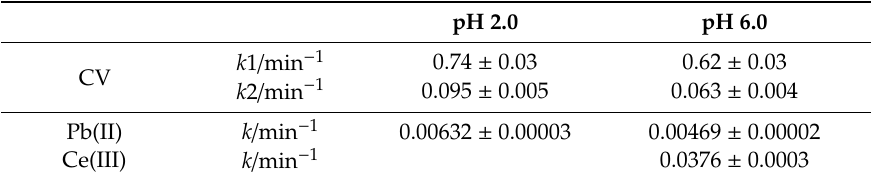
Table 4. Rate constant values for pseudo-first order and double exponential models applied to the kinetic profiles of adsorption of the pollutants onto K10-Mt.